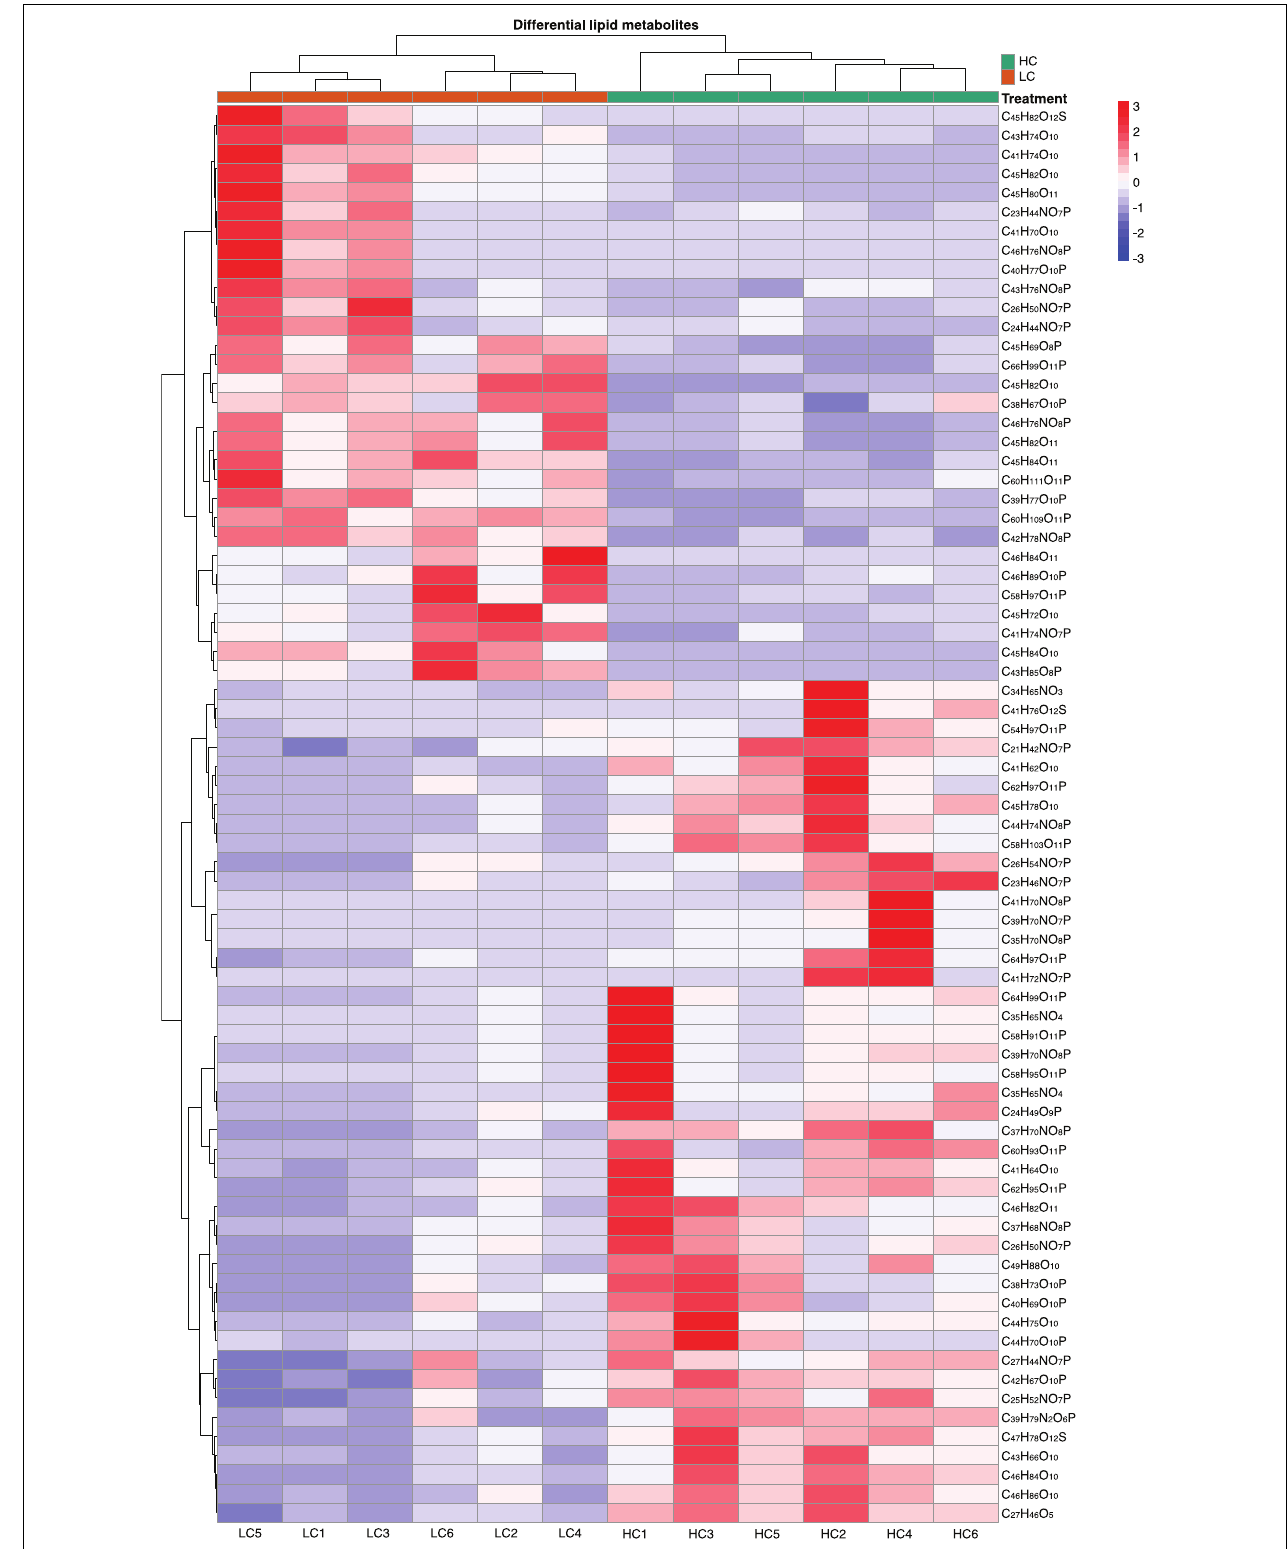
FIGURE 2 | Heatmap displaying the log 2 -fold change in lipid metabolite between low (400 µ atm, LC) and high (1,000 µ atm, HC) CO 2 selected Phaeodactylum tricornutum cells.